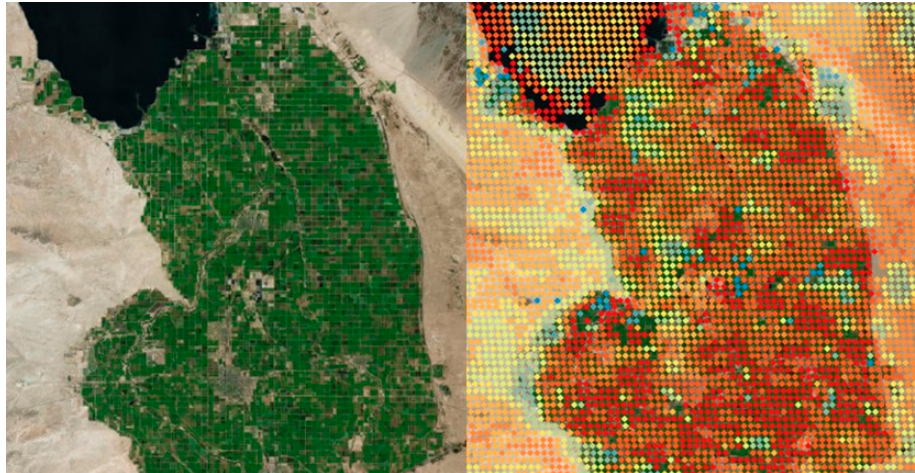
Figure 15. True color image ( left panel ) of the Imperial Valley cropland area, with positive BFAST LST slope values in orange-red shades and negative LST slope values in blue shades ( right panel ); no change in LST pixels are shaded in yellow. The map is upward in the northern direction.